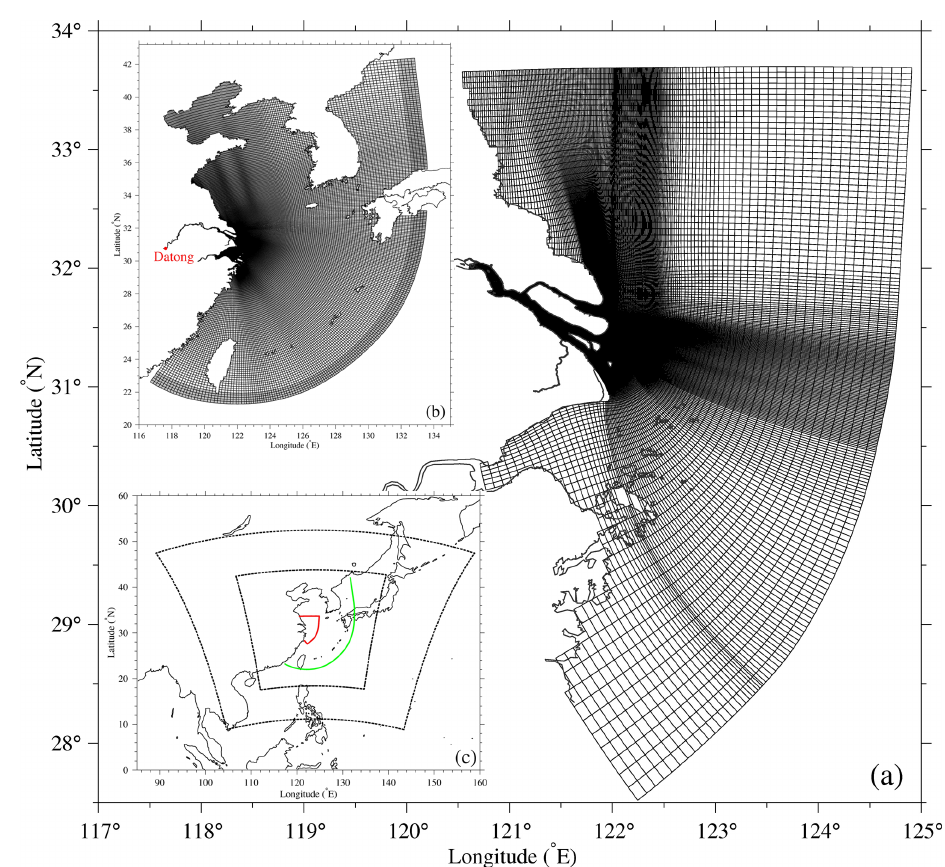
Figure 2. Model grids of the Changjiang estuary (a) and model grids of the Bohai Sea, Yellow Sea and East China Sea (b) . Domains of the models: within the red line – the Changjiang estuary model domain; within the green line – model domain of the Bohai Sea, Yellow Sea and East China Sea; black dashed lines – the two-fold nested Weather Research and Forecasting (WRF) model domain (c)